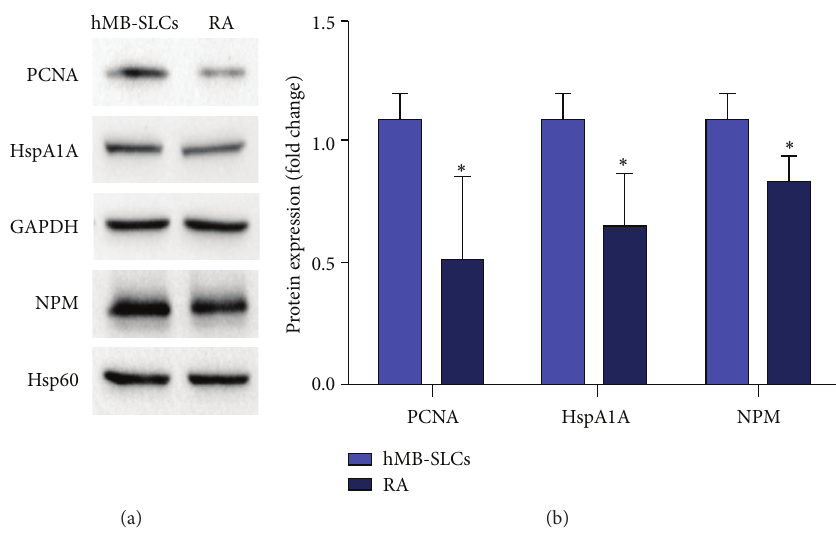
Figure 5: WB validation. (a) Western blot analysis of NPM, PCNA, and HspA1A in hMB-SLCs and in 48h RA-treated cells. Hsp60 and GAPDH were used as control for equal protein load. (b) Densitometric analysis confirmed the significant differential expression observed by proteomic analysis. The protein expression, normalized to Hsp60 expression for NPM and GAPDH expression for the other proteins, represents the mean ± SEM from three independent experiments. ∗ denotes 𝑝 < 0.05 versus hMB-SLCs.